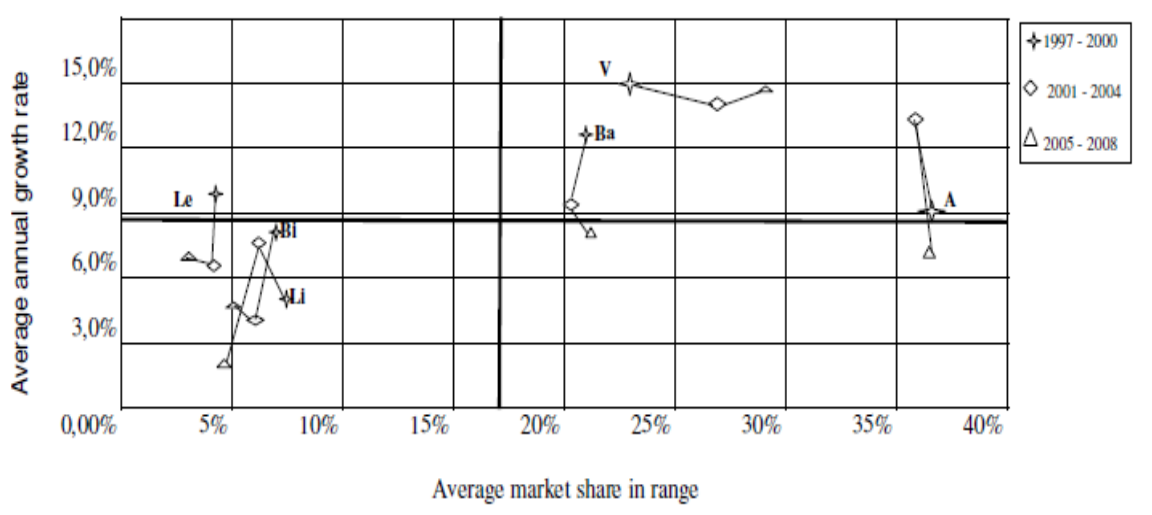
Figure 11: Dynamic portfolio analysis of container traffic